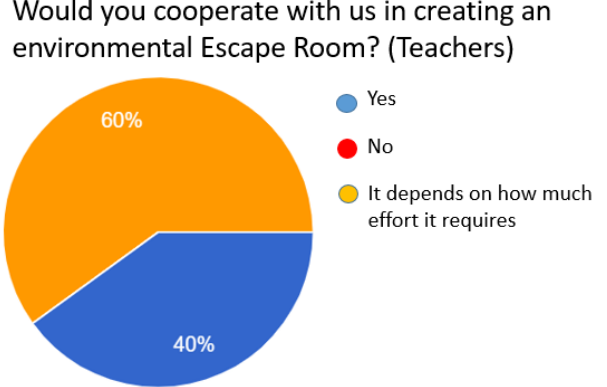
Figure 12. Pie chart showing cumulative percentage of the feedback received for the fifth question from teachers, concerning all the played Salvina’s adventures.